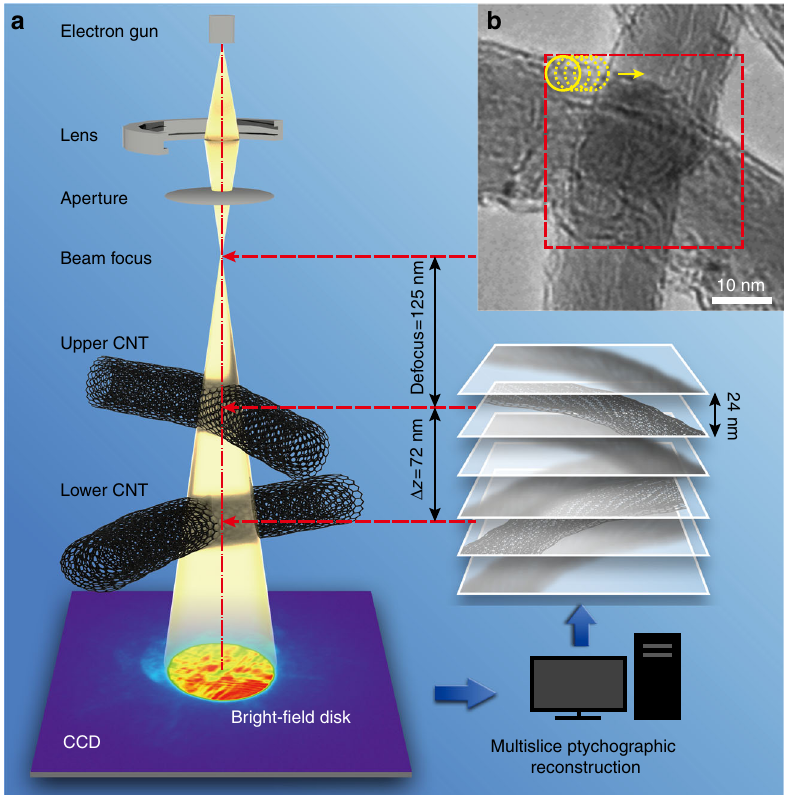
Fig. 1 Schematic of the experimental set-up. a Optical geometry of the experiment. b TEM image of the CNTs; the red box indicates the region from which ptychographic data were recorded. The upper tube was placed at a distance, df = 125 nm below the probe focus. The height separation of the tubes is Δ z = 72